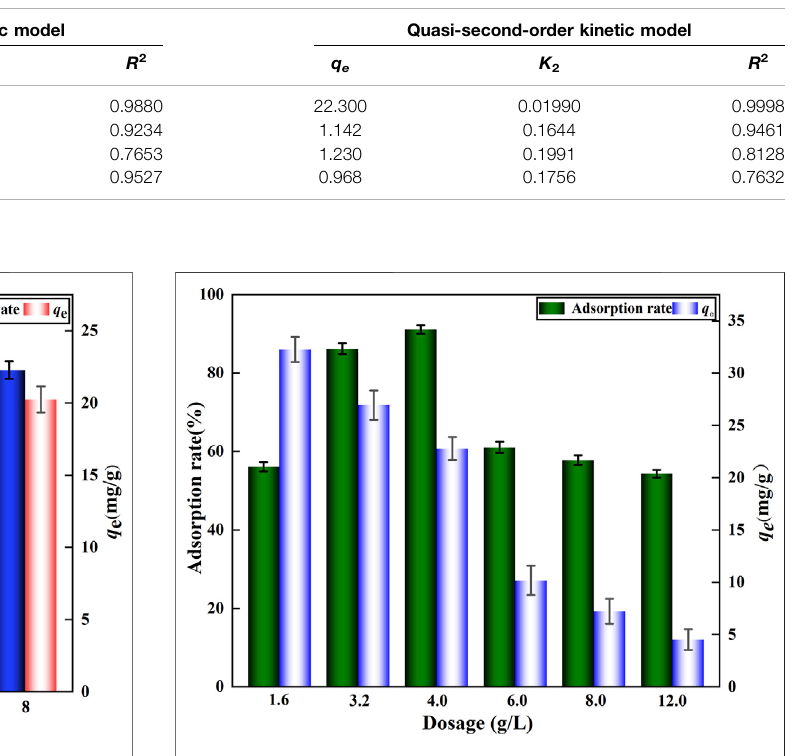
FIGURE 6 | Effect of DA on F - adsorption at different pH levels. FIGURE 7 | Effects of different dosages of DA on F -